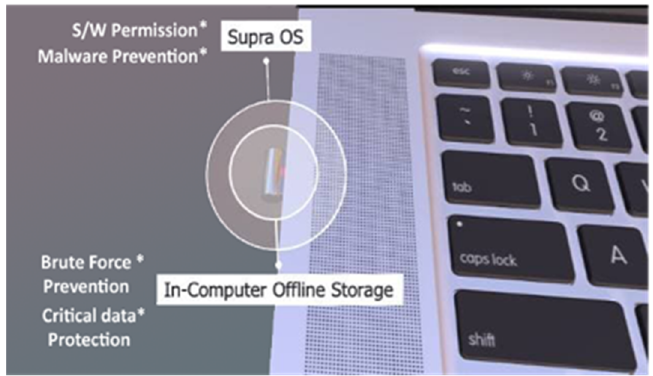
Figure 5. Comparison of architectural constructs of 3rd party permissions and attack surface be- tween legacy IoT systems and ZVC